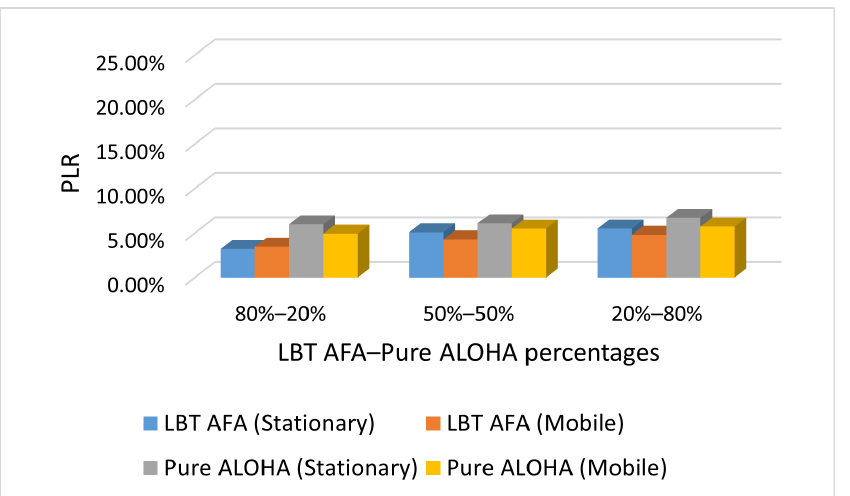
Figure 4. Case L: PLR with varying percentages of end-devices that use Pure ALOHA and LBT AFA.